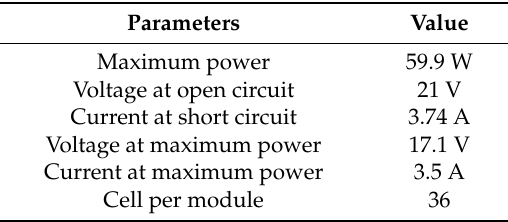
Figure 6. The configuration of the PV array ( a ) weak shading; ( b ) strong shading. Table 1. PV module specifications.